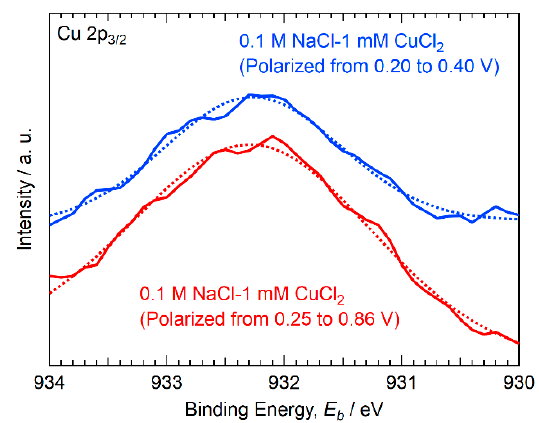
Figure 7. Cu 2p X-ray photoelectron spectroscopy (XPS) spectra of 316EHP stainless-steel in 0.1 3/2 polarized from 0.20 to 0.40 V and polarized from 0.25 to 0.86 M NaCl-1 mM CuCl 2